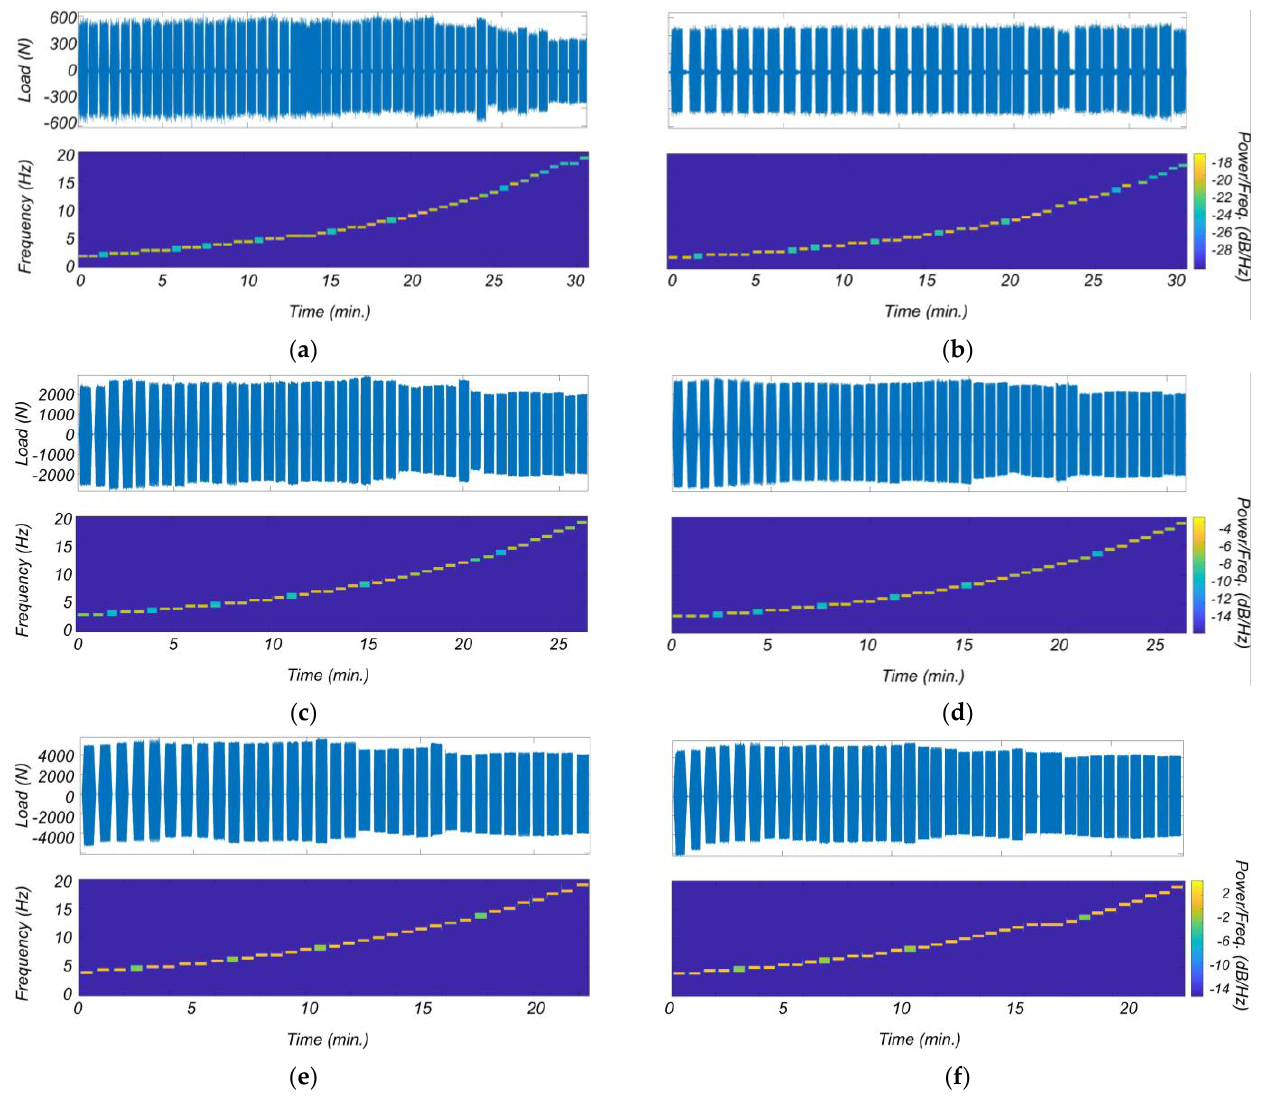
Figure 7. Excitation force time histories and instantaneous excitation frequencies: ( a ) Layout 1 with 445 N target load amplitude, ( b ) Layout 2 with 445 N target load amplitude, ( c ) Layout 1 with 2225 N target load amplitude, ( d ) Layout 2 with 2225 N target load amplitude, ( e ) Layout 1 with 4450 N target load amplitude, and ( f ) Layout 2 with 4450 N target load